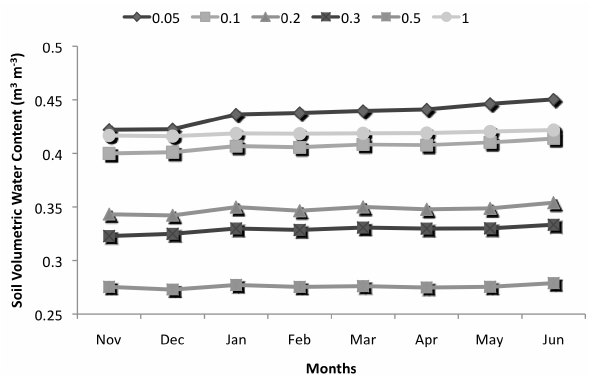
Fig. 4. Monthly average of the soil volumetric water content at six different levels below the surface (in meters) from November 2008 to June